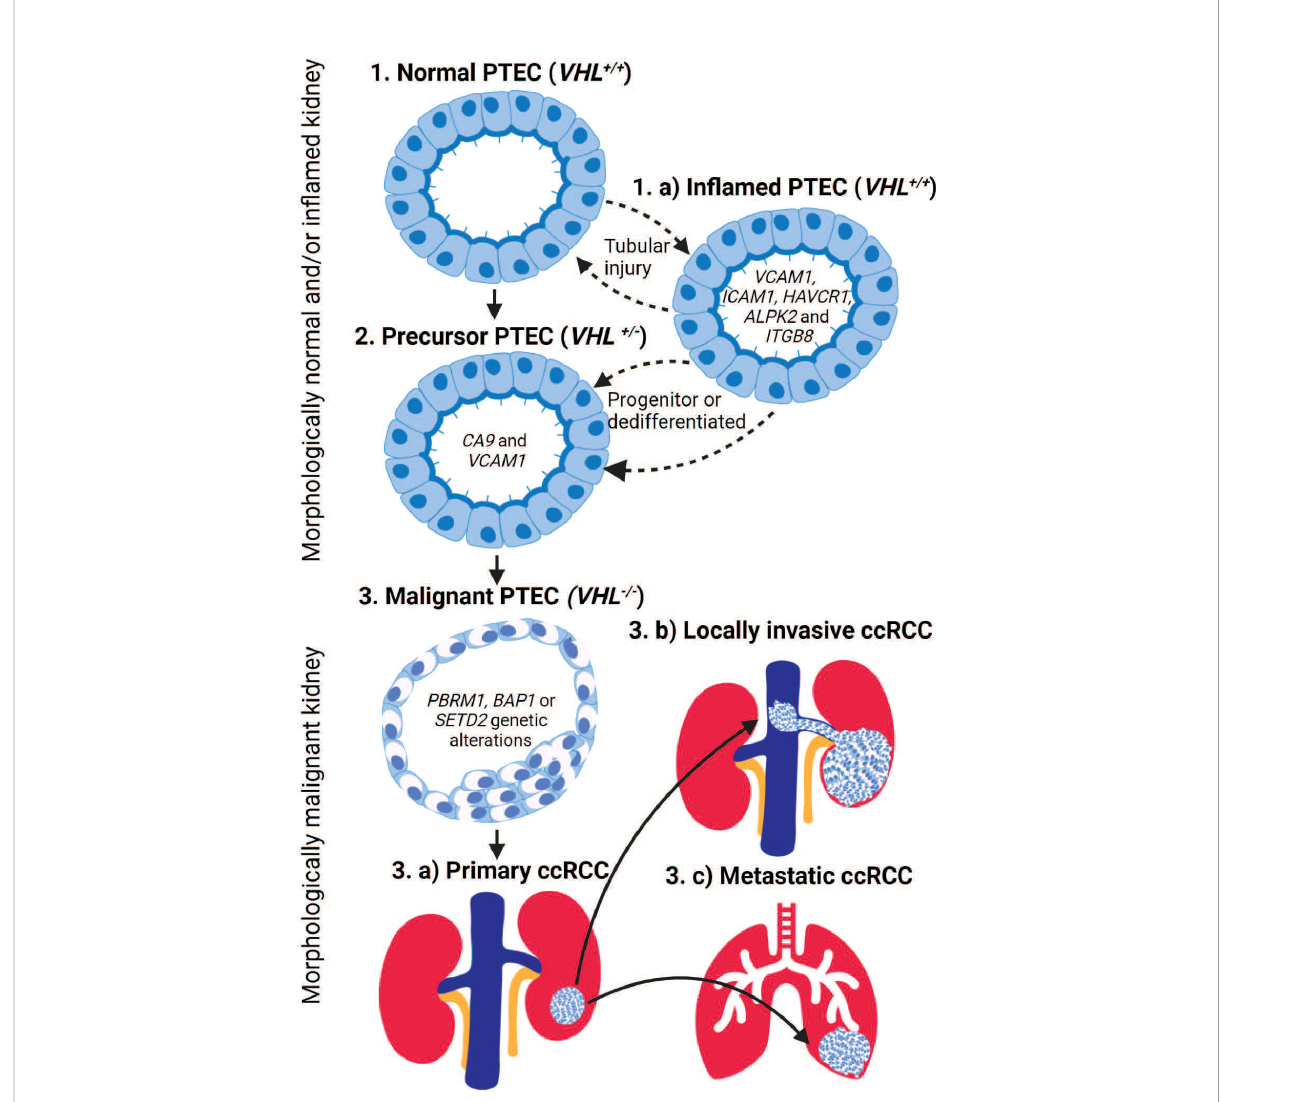
FIGURE 1 The transition of proximal tubular epithelial cells (PTEC) in the development of ccRCC. PTEC are the cell of origin in ccRCC that under hypoxic conditions transition from normal to malignant state. PTEC transition from normal (Step 1) to precursor VHL +/- (Step 2) and fi nally malignant VHL -/- (Step 3) after additional genetic alterations are acquired. Alternatively, under hypoxic conditions, PTEC may transition to an in fl amed PTEC VCAM (Step 1.a) state due to tubular injury. This in fl amed PTEC state is bidirectional until a loss of VHL +/- within the in fl amed PTEC is acquired, resulting in the non-reversible transitions to the precursor PTEC (Step 2) state and fi nally the malignant (Step 3) state after the loss of both VHL -/- and additional genetic alterations are acquired. Once PTEC transition to the malignant state, they can develop primary ccRCC (Step 3.a) lesions within the kidney or locally invasive ccRCC (Step 3.b) lesions that extend into adjacent large vessels and/or metastatic ccRCC (Step 3.c) lesions that spread to distant